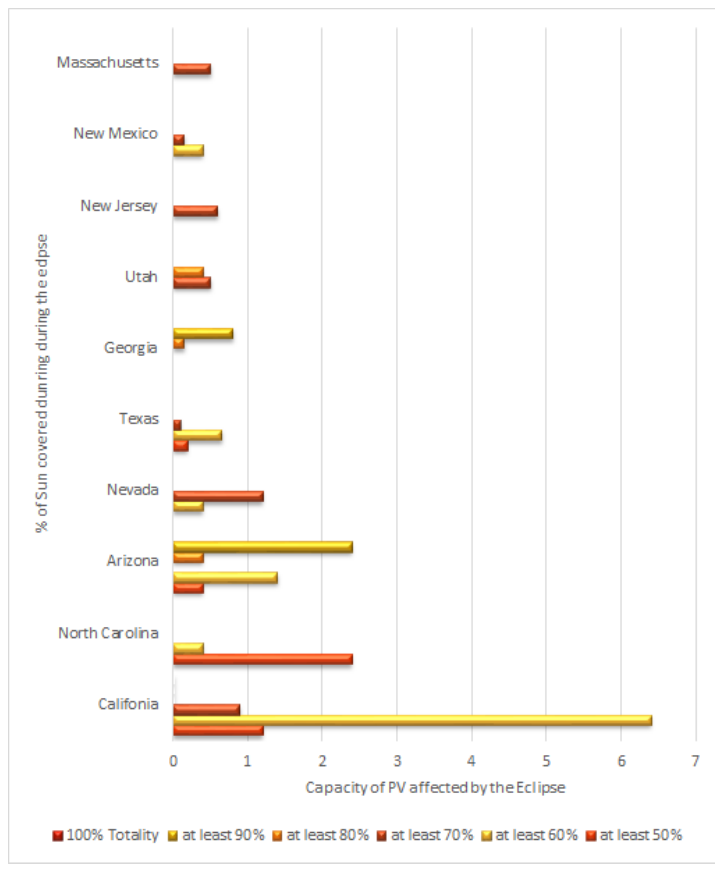
Figure 6. The effect of 21 August 2017 on PV generators in the